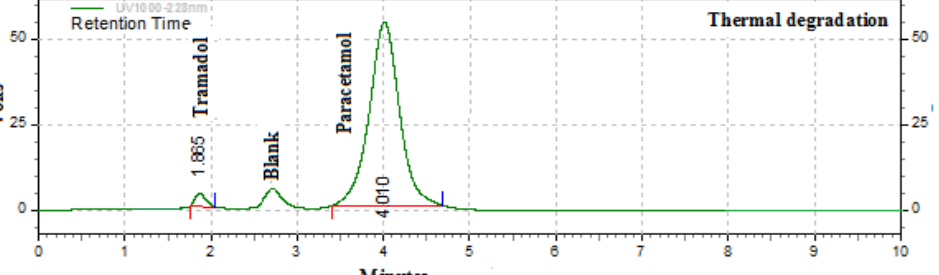
Figure 7 . Representative chromatogram obtained from thermal degradation at